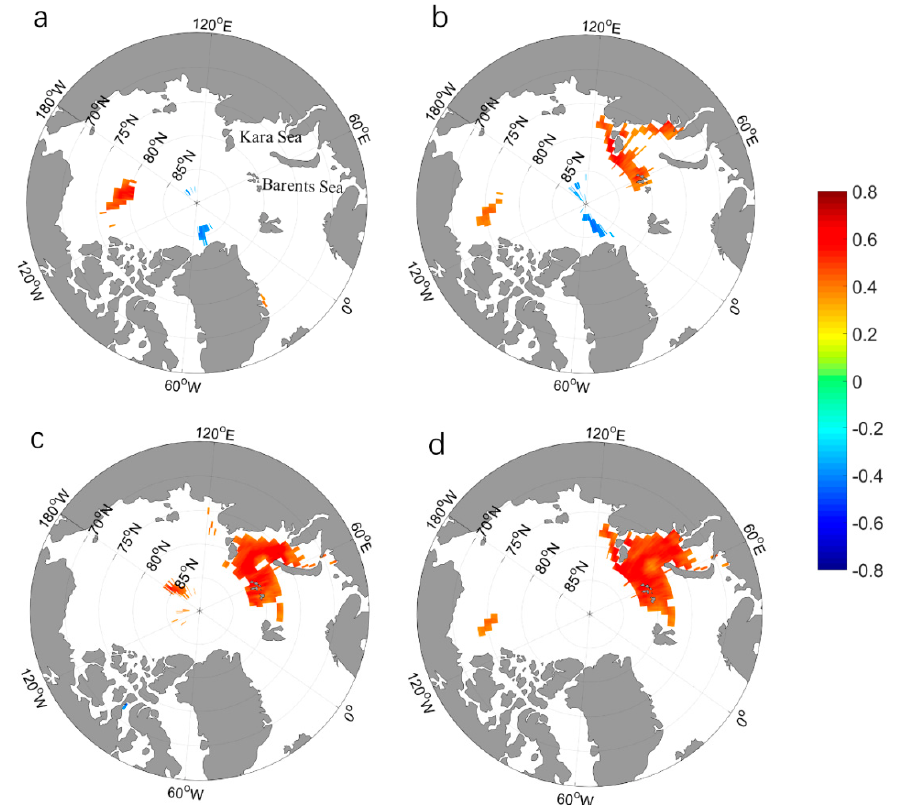
Figure 4. ( a ) The correlation coefficient distribution between the principal component time series of the winter Eurasian snow water equivalent empirical orthogonal function mode 2 and autumn Arctic sea ice concentration in September, ( b ) October, ( c ) November, and ( d ) October–November. The colored regions passed the t-test with a confidence level of 95%. All of the series have been detrended.